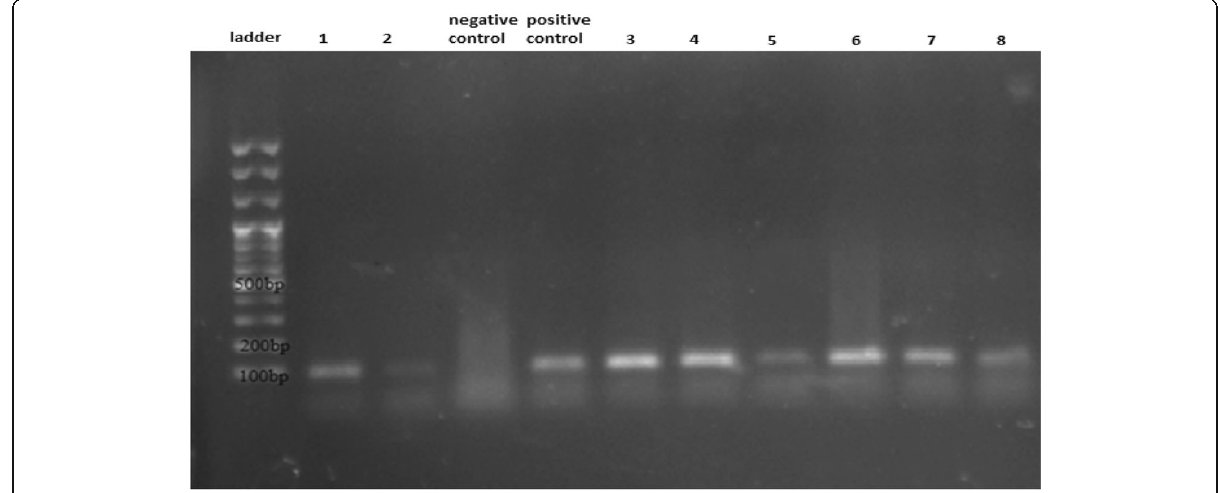
Fig. 1 We evaluated the quality of DNA extraction by PCR with β -globin gene (100 bp), as an internal control to confirm the accuracy of DNA extraction